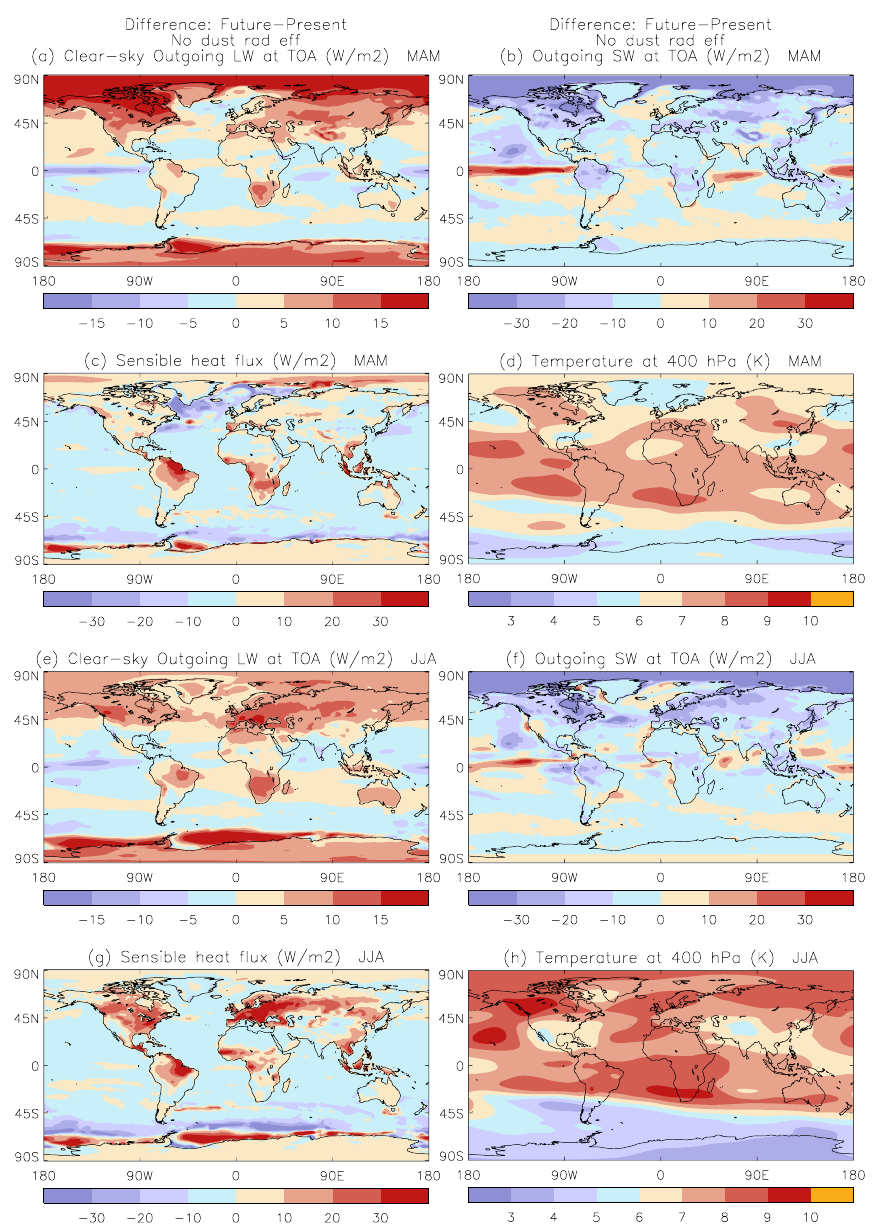
Fig. 16. Global differences between future timeslice and present-day simulations using HadGEM2-A (and no dust radiative effects): (a) clear- sky outgoing longwave radiation at TOA; (b) outgoing shortwave radiation at TOA; (c) surface sensible heat flux; (d) temperature at 400hPa, for MAM, and (e) – (h) similar for